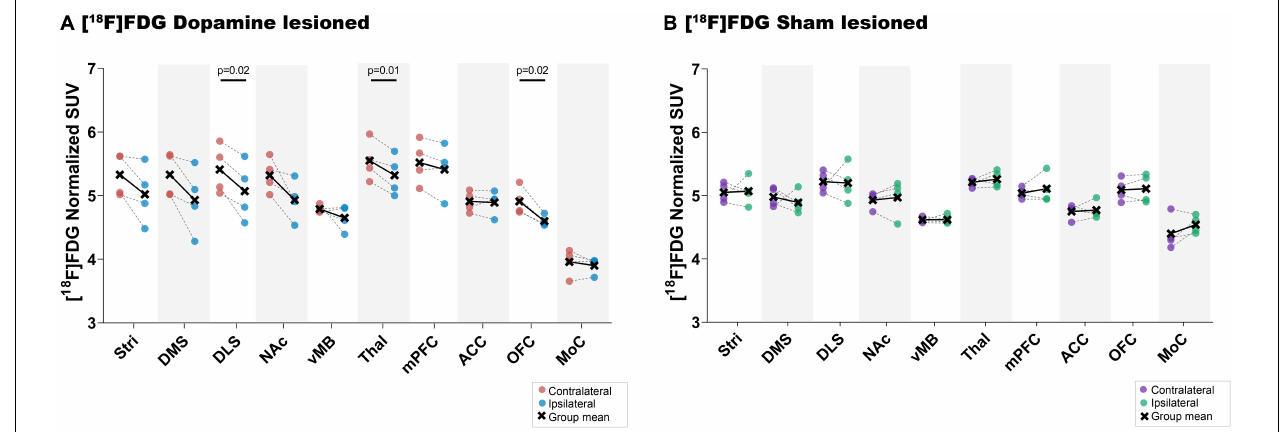
FIGURE 5 | [ 18 F]FDG uptake. Direct comparison between ipsilateral and contralateral hemispheres of normalised [ 18 F]FDG uptake in all regions of interest within the dopamine lesioned (A) and sham lesioned (B) rats. Notable differences were marked with their uncorrected p values. Stri = striatum, DMS = dorsomedial striatum, DLS = dorsolateral striatum, NAc = nucleus accumbens, vMB = ventral midbrain, Thal = thalamus, mPFC = medial prefrontal cortex, ACC = anterior cingulate cortex, OFC = orbitofrontal cortex, MoC = motor cortex.